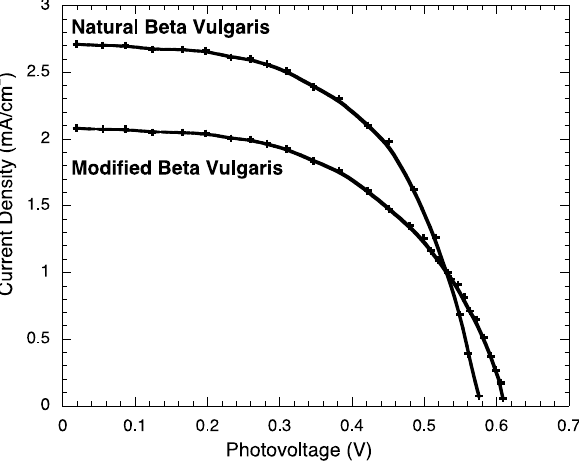
Figure 4. Photocurrent-photovoltage curves for BVE and BVE/TEOS solar cells.